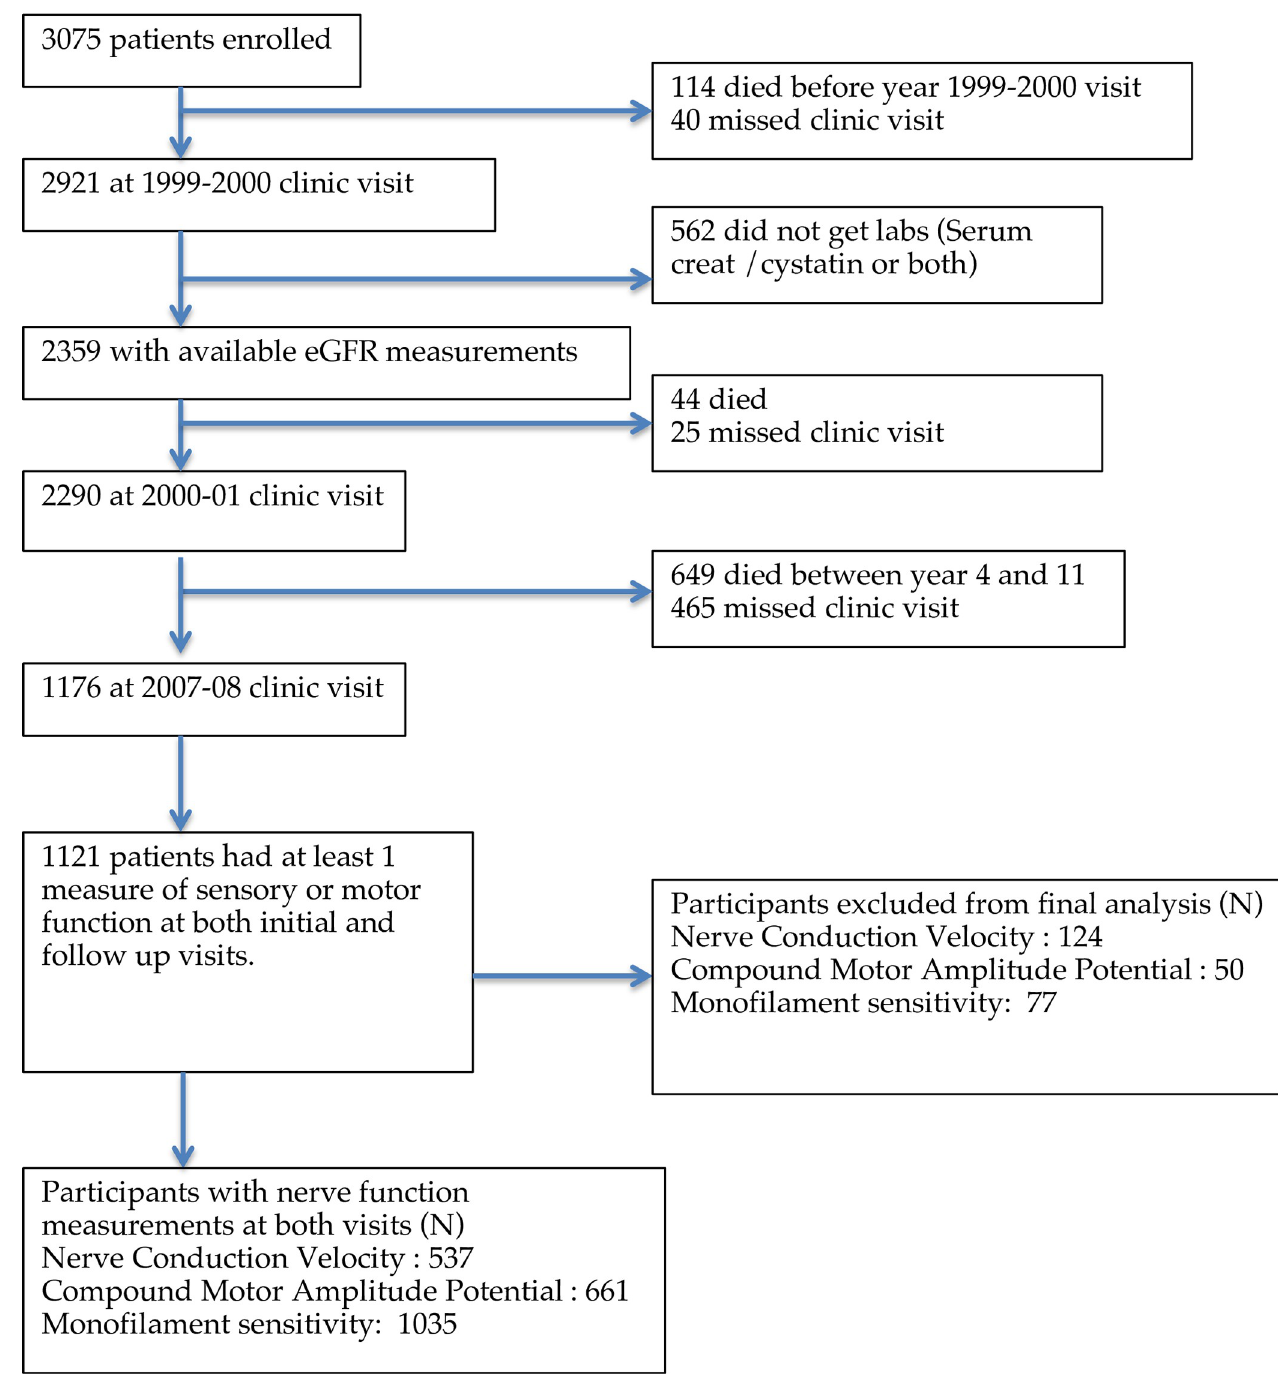
Fig 1. Participants included in analyses (N = 1121). used to classify participants as having CKD ( � 60 ml/min/1.73m 2 ) or non-CKD ( > 60 ml/min/ 1.73m 2 ). Serum creatinine was measured from blood collected after an overnight fast by a col- orimetric assay using a Vitros 950 Analyzer (Johnson & Johnson, New Jersey, USA) calibrated